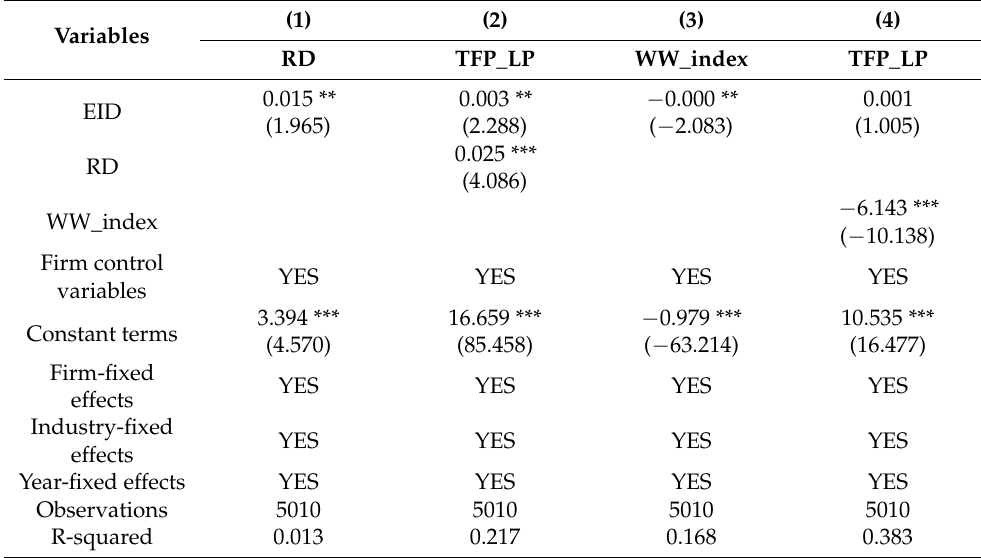
Table 9. Mechanism analysis: innovation incentives and financing